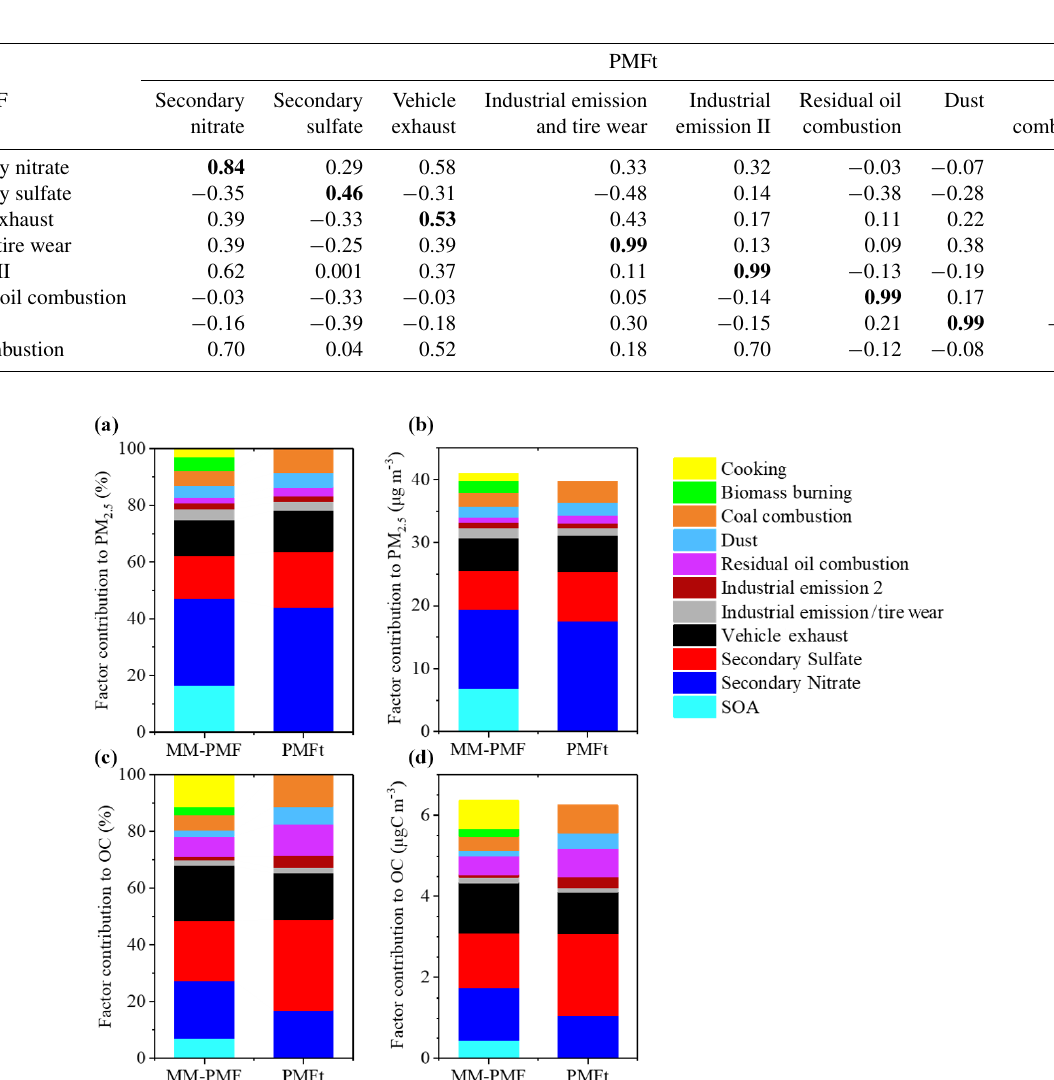
Table 3. Correlation ( R ) of common source factors between PMF t and MM-PMF. The highest correlation for each factor was highlighted in bold.